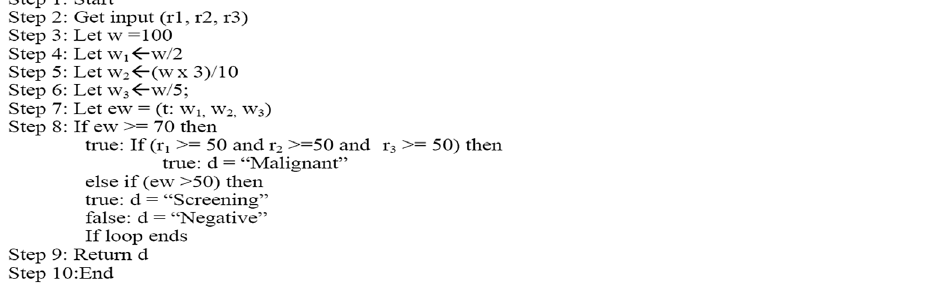
Figure 2. Weighted voting algorithm 21